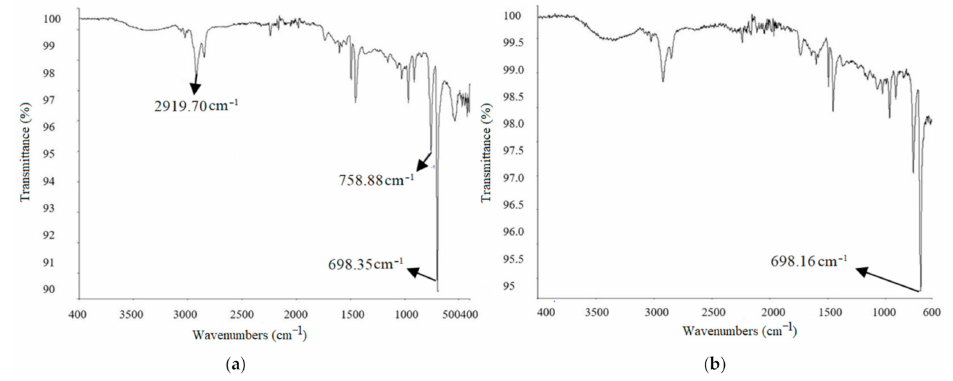
Figure 17. FTIR graphs of ABS composites ( a ) C7 and ( b ) C8